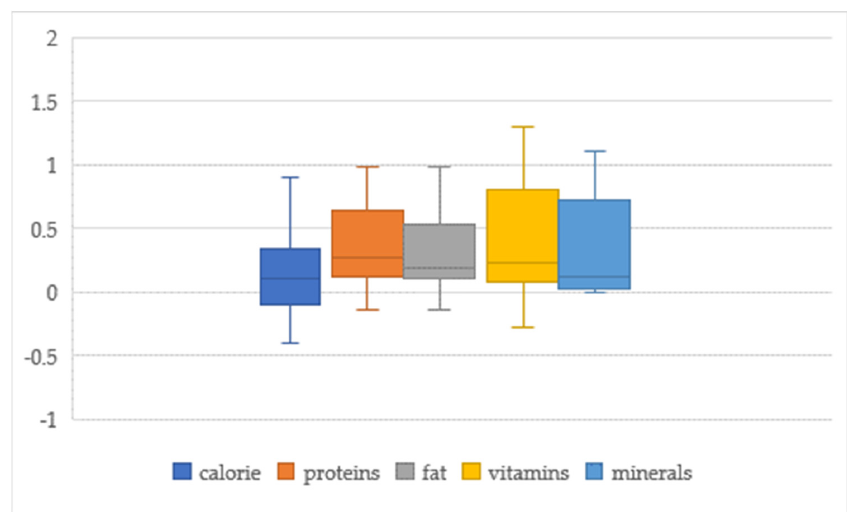
Figure 1. Box plot of food–income elasticities synthesis.